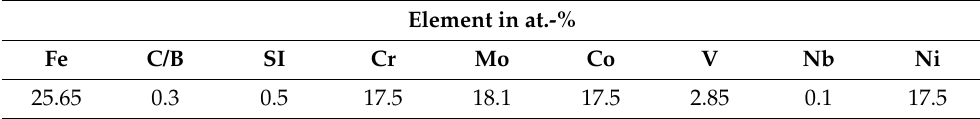
Table 2. Intended chemical composition of the used HEA in advance of